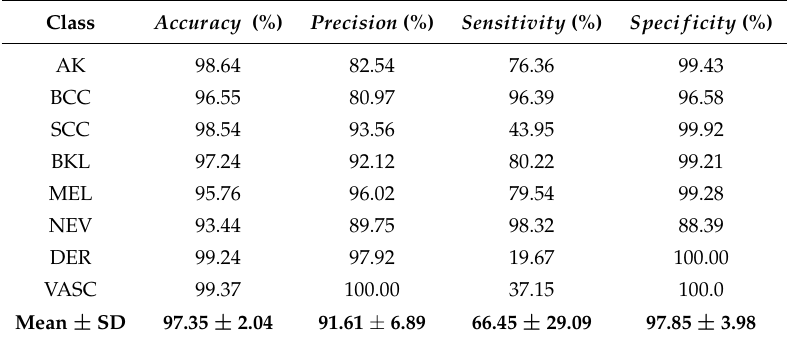
Table 4. The performance metrics obtained from the values in Table 3 for the Exp-1 with α = − 2.0.